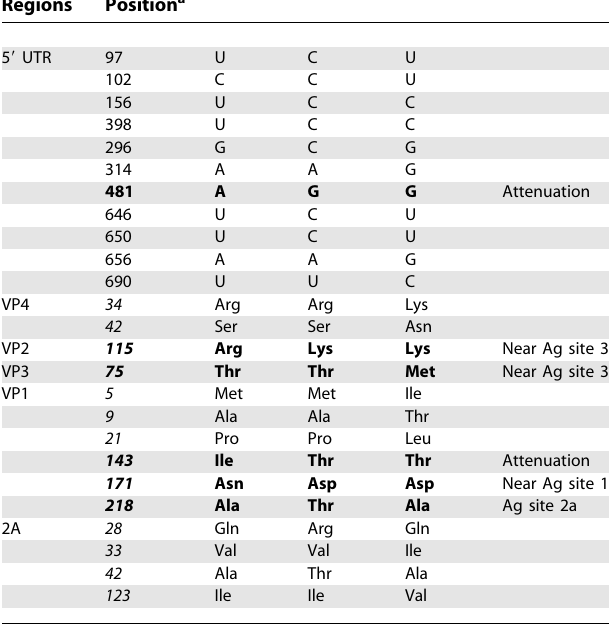
Table 1. Nucleotide Substitutions and Nonsynonymous Codon Changes in the Vaccine Part of the Genome of the Madagascan VDPVs Genomic Nt or a.a. Regions Position